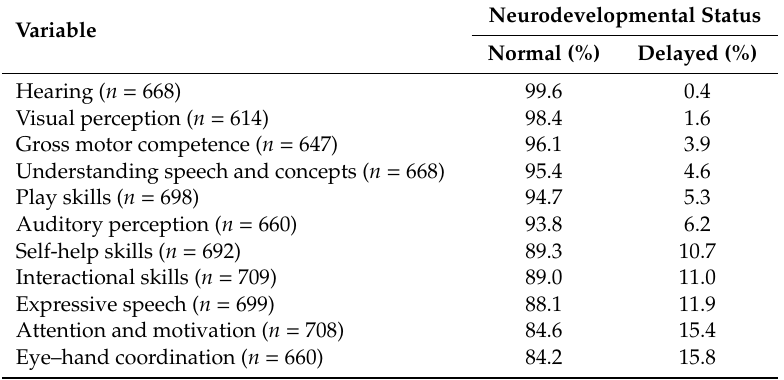
Table 1. The distribution of neurological variables in 2.5-year-old children ( n = 717), as measured by the Lene test.